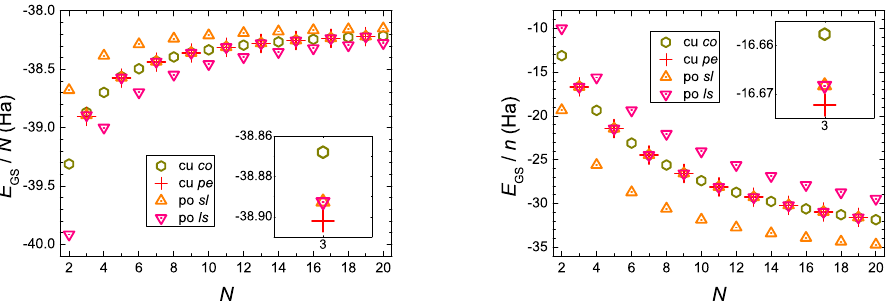
Figure 6. Ground state energy of neutral molecules, E GS , B3LYP/cc-pVTZ level of theory. N is the number of carbon atoms and n is the number of all atoms, cu co (cu pe ) denotes cumulenic molecules with coplanar (perpendicular) methylene groups, po sl (po ls ) denotes polyynic molecules starting with short (long) bonds. ( Left ) E GS / N as a function of N . ( Right ) E GS / n as a function of N . The insets emphasize that, for odd N , the cu pe (cu co ) molecule has the lowest (highest) E GS